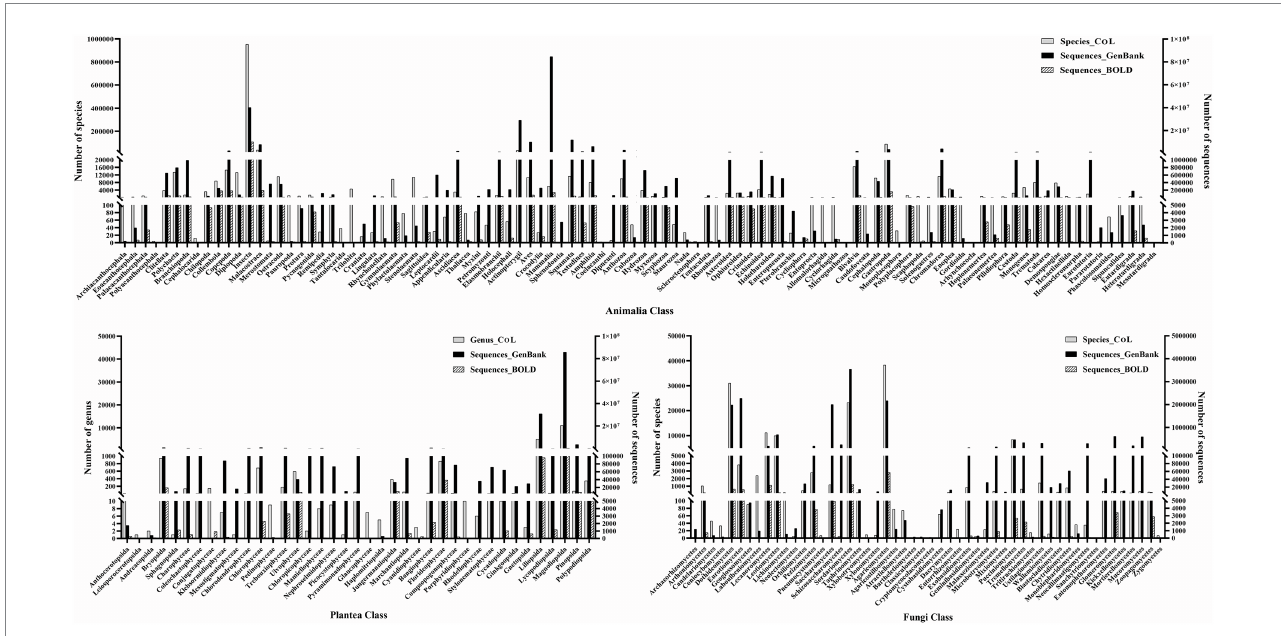
FIGURE 1 Statistics of species/genus number and gene sequences at class level in Animalia, Plantae and Fungi.